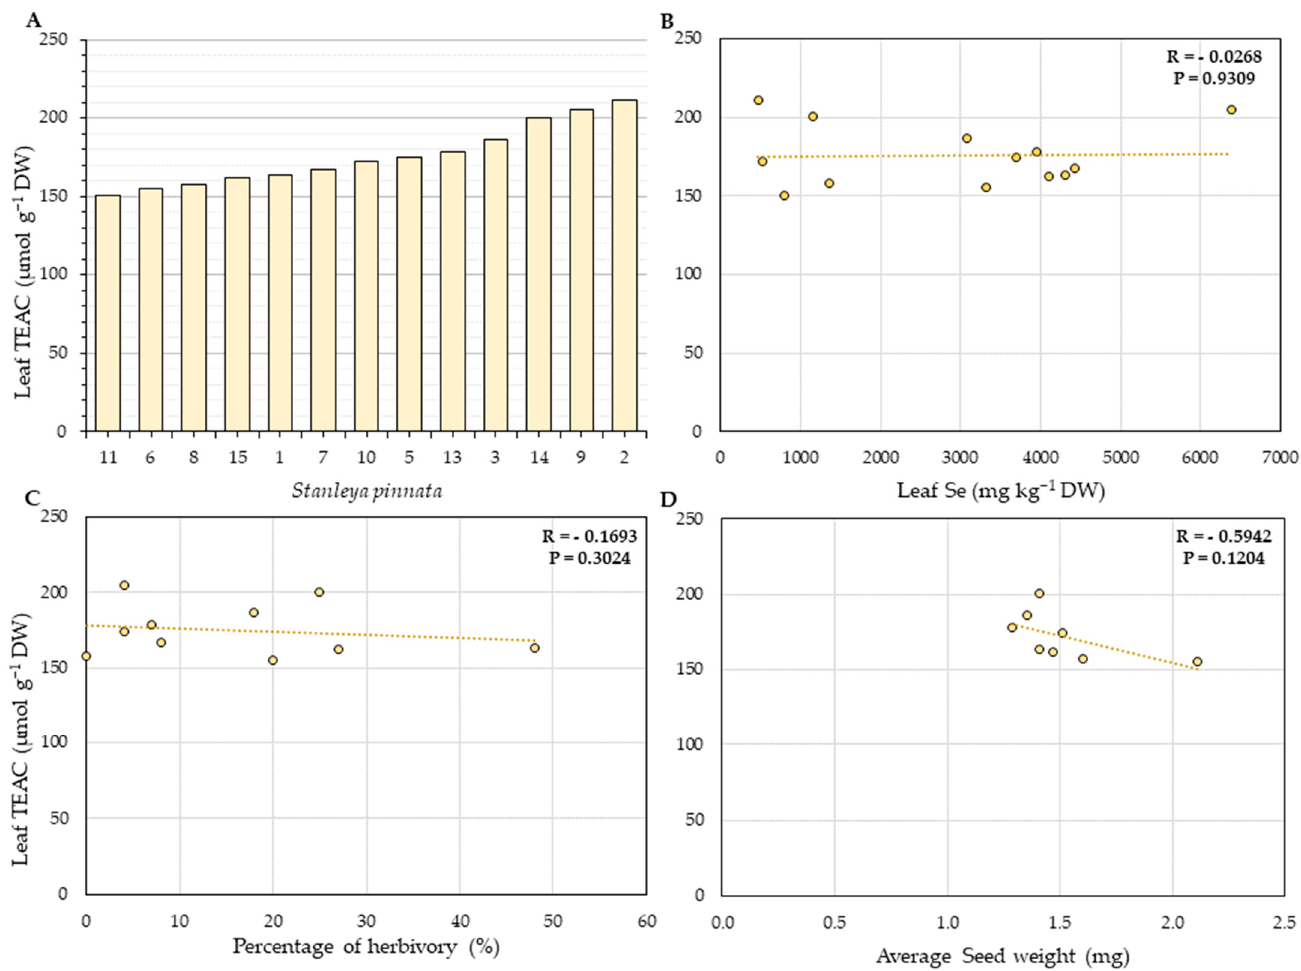
Figure 9. ( A ) Total antioxidant capacity in leaves of S. pinnata plants (Pine Ridge), expressed as Trolox (Vitamin E equivalents) antioxidant capacity (TEAC). The error bars in panel ( A ) represent the standard deviation of the mean from three technical replicates per plant. ( B – D ) Correlation between leaf TEAC (vertical axis) with leaf Se concentration ( B ), percentage of herbivory ( C ), and average seed weight ( D ). The numbers on the horizontal axis ( A ) represent the collection numbers for individual plants at the locations indicated in Figure 3. The graphs show the correlation coefficient R and p -value for panels ( B – D ).